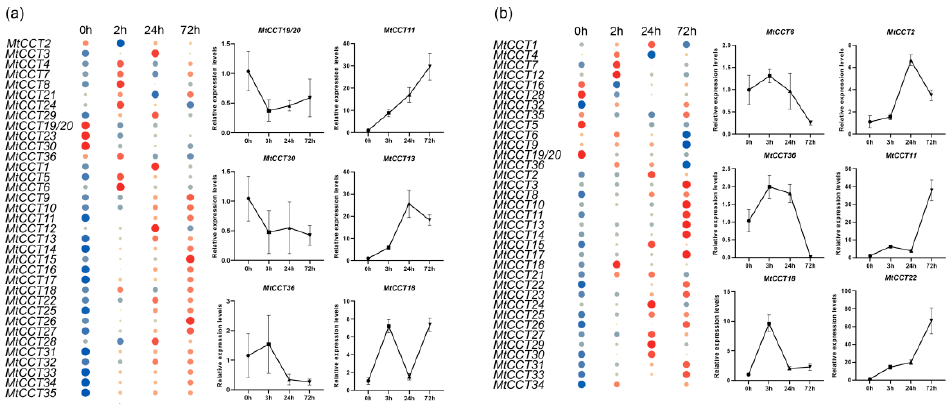
Figure 7. Expression of MtCCT genes in response to abiotic stress. Plants with fourth blade were watered with 0.3 M NaCl ( a ) and 17% PEG (polyethylene glycol) ( b ). Expression levels are normalized to MtACTIN and error bars indicate standard deviation among three biological replicates. The relative expressions levels are -log2 transformed and visualized for heat map. The colors vary from blue to red, and circles from small to large represent the scale of the relative expression levels.